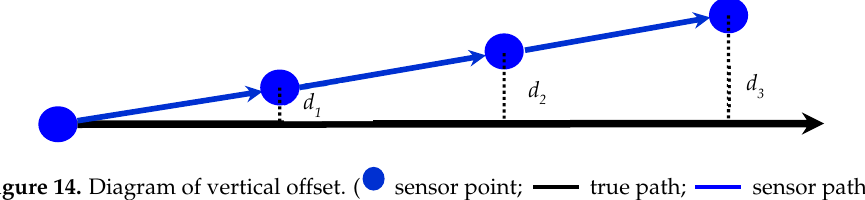
Table 3. Basic Attributes of the Fields.